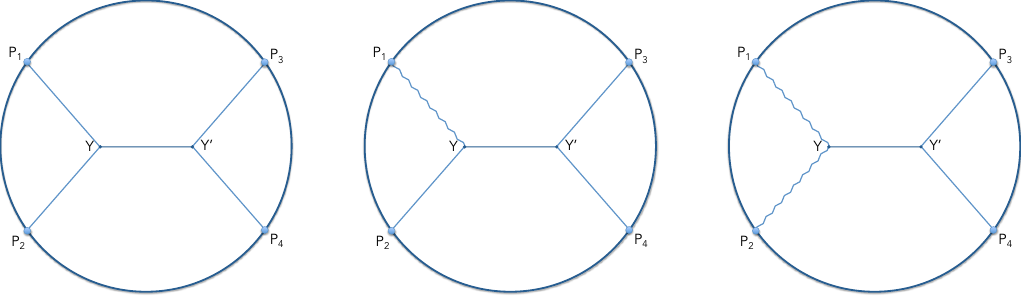
Figure 5 . Four-point exchange Witten diagrams in AdS d +1 , where the exchanged (cid:12)eld is a scalar (cid:12)eld of dimension (cid:1). The (cid:12)rst diagram corresponds to A Exch A Exch in (5.9), and the third diagram to A Exch 1 ; 0 ; 0 ; 0